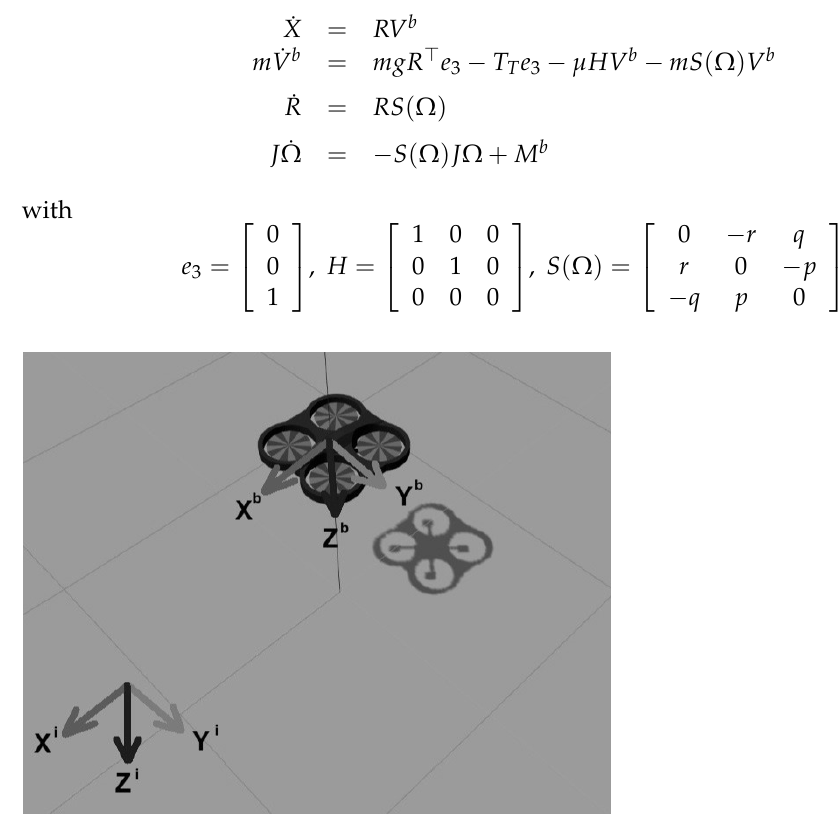
Figure 1. Inertial X i Y i Z i and Body X b Y b Z b